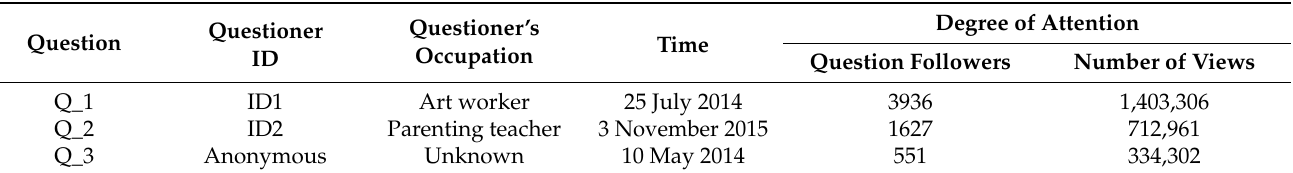
Table 2. Basic information on the three studied questions posted on the Zhihu website.